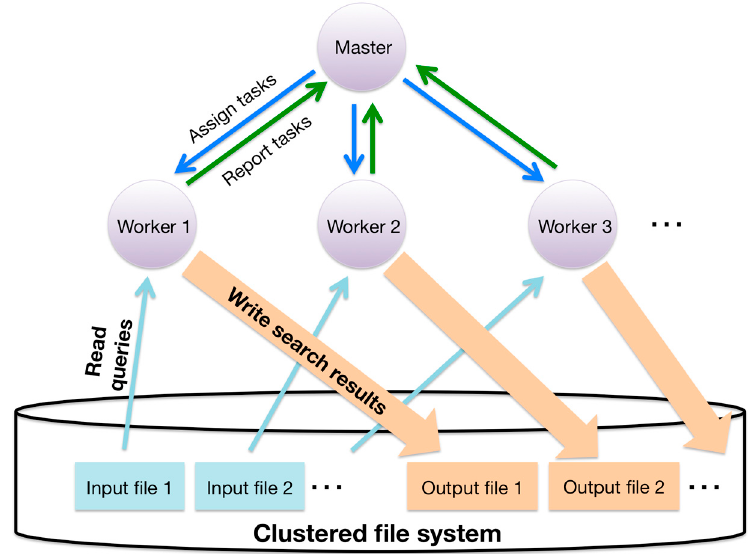
Figure 6. Schematic of task distribution and file I/O (Input/Output) in GHOST-MP.